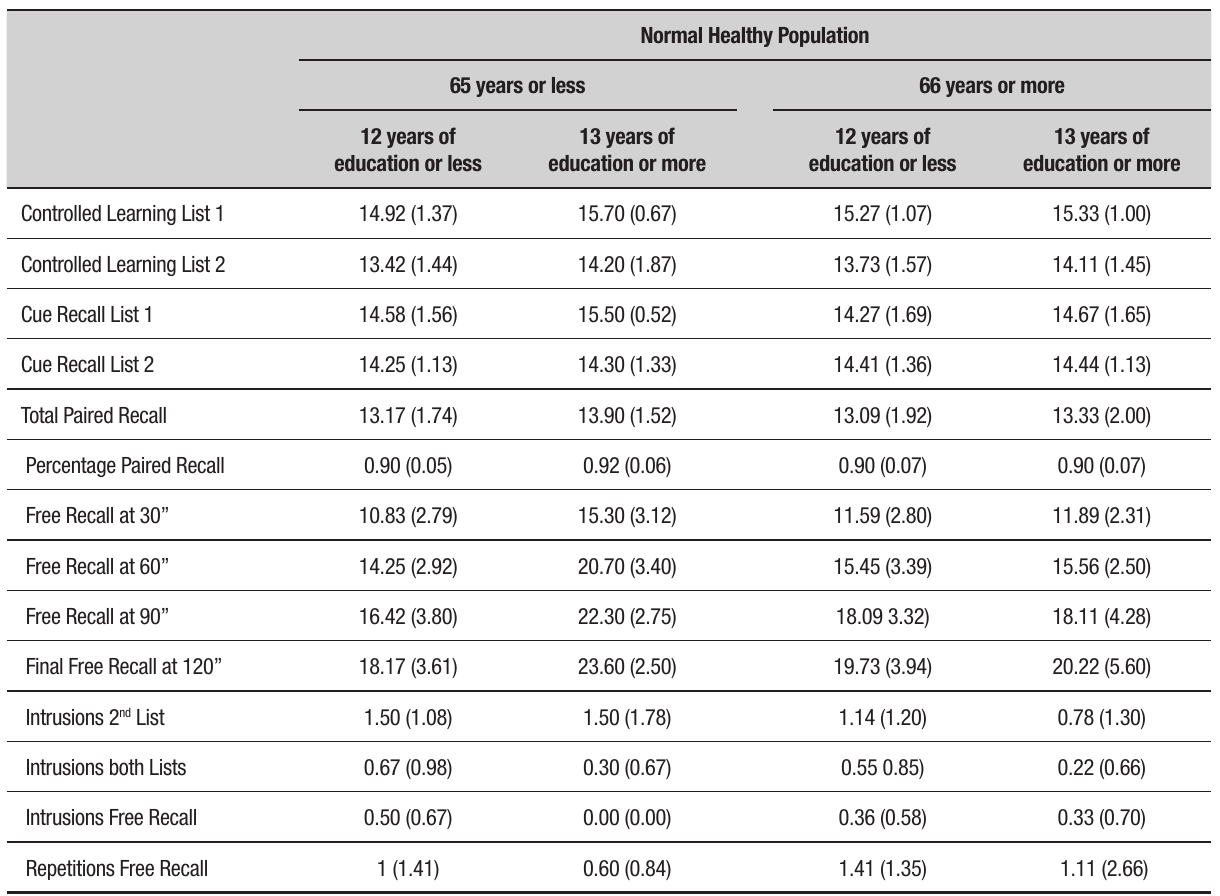
Table 3. MBT: Norms in normal healthy